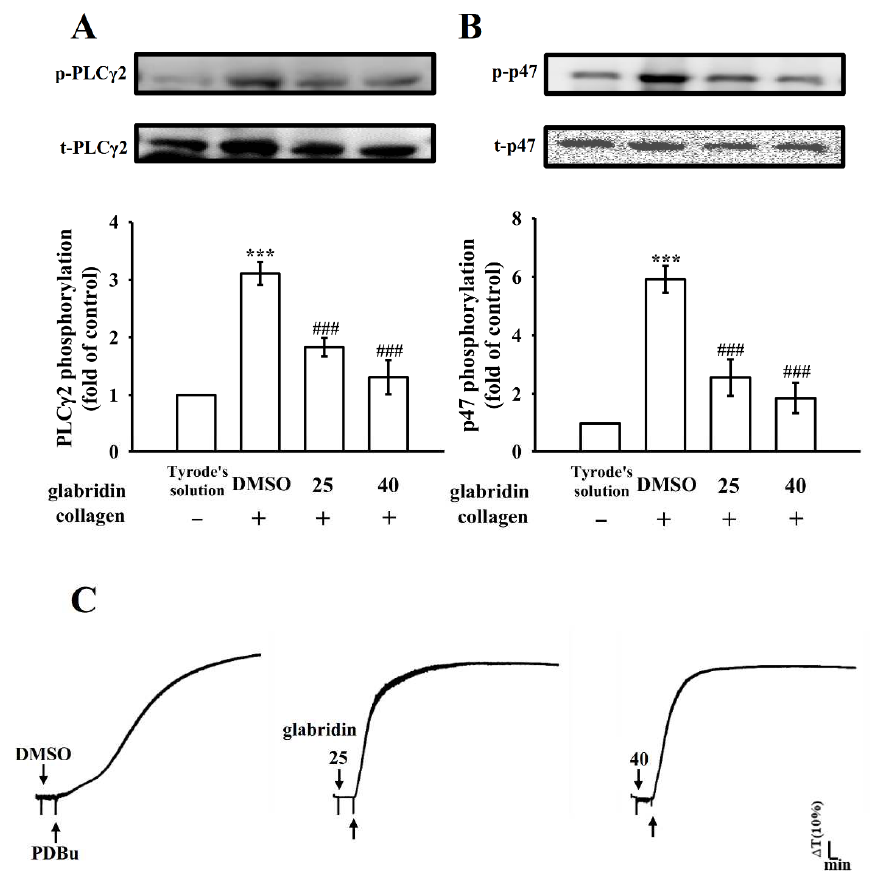
Figure 3. Effects of glabridin on the activation of phospholipase C γ 2 and protein kinase C in platelets. DMSO (0.1%) or glabridin (25 and 40 µ M) were preincubated in washed platelets,